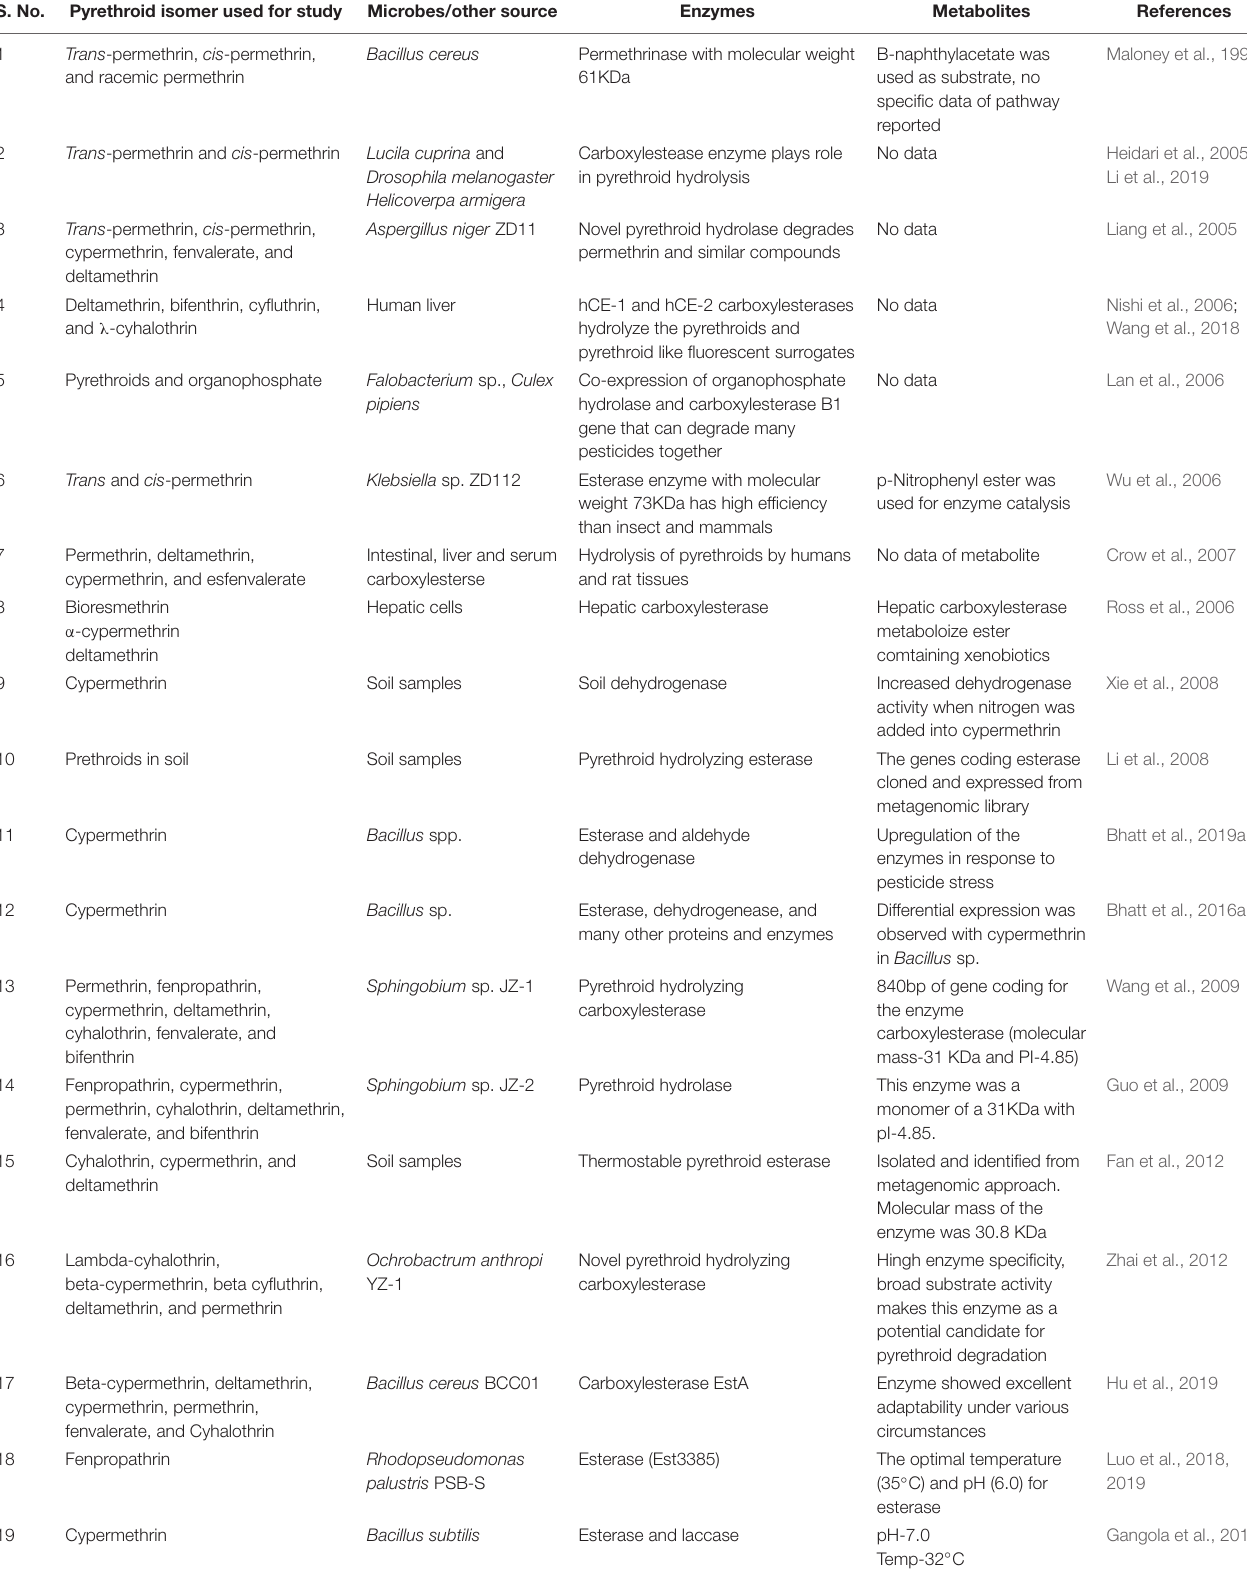
TABLE 4 | Pyrethroid degrading enzymes from different